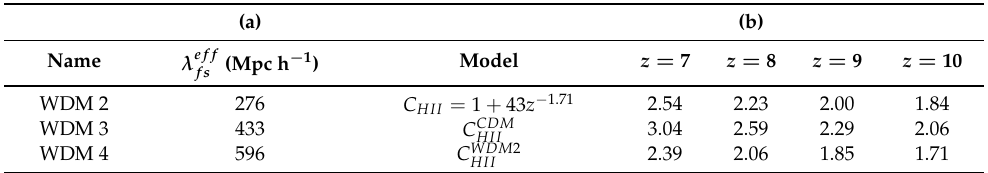
Table 4. (a) : free-streaming length for thermal WDM models. (b) : evolution of C HII with z for our fiducial and for the Trombetti model [56].